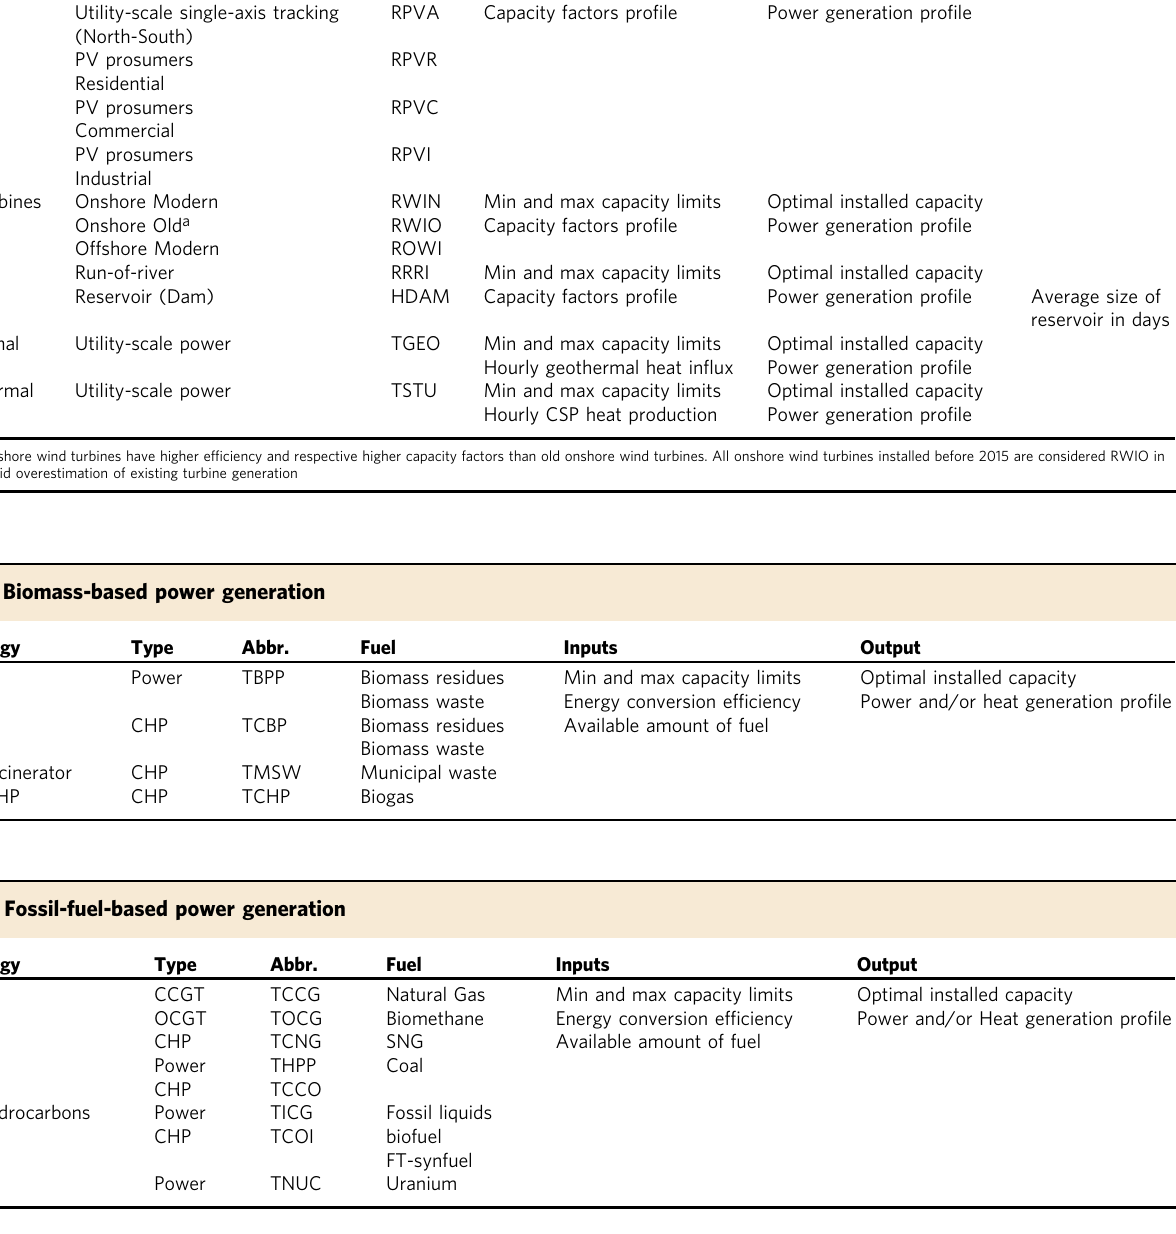
Table 2 Renewable-based power generation Technology